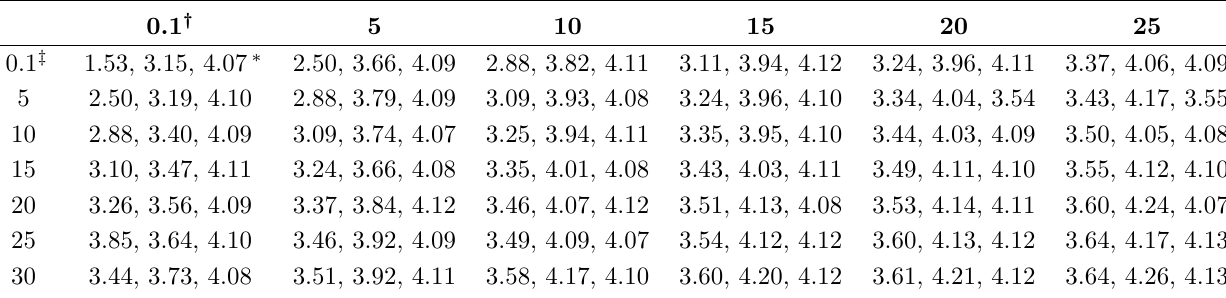
Table 2. Achieved RMSEs over different movement modes.